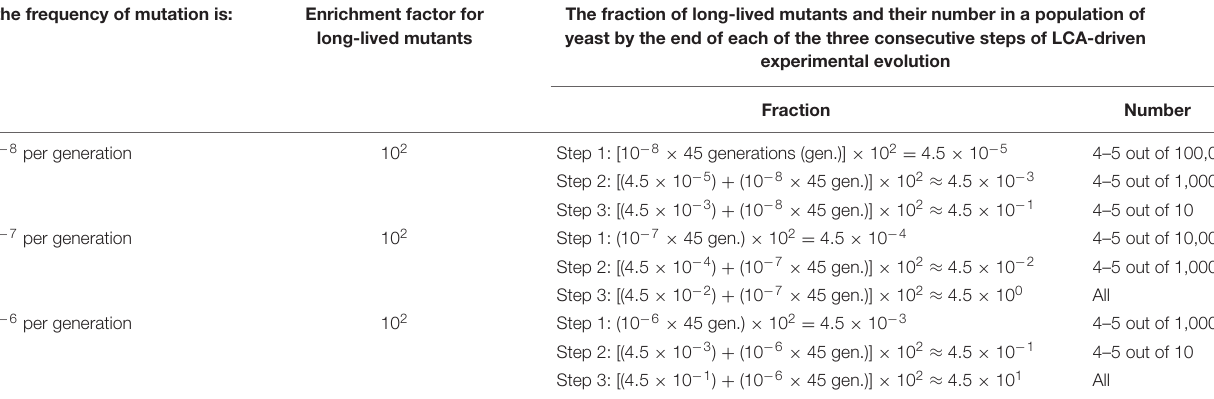
For each selection step, the number of cell generations and enrichment factor for long-lived mutants were calculated as shown in Figure 1 .